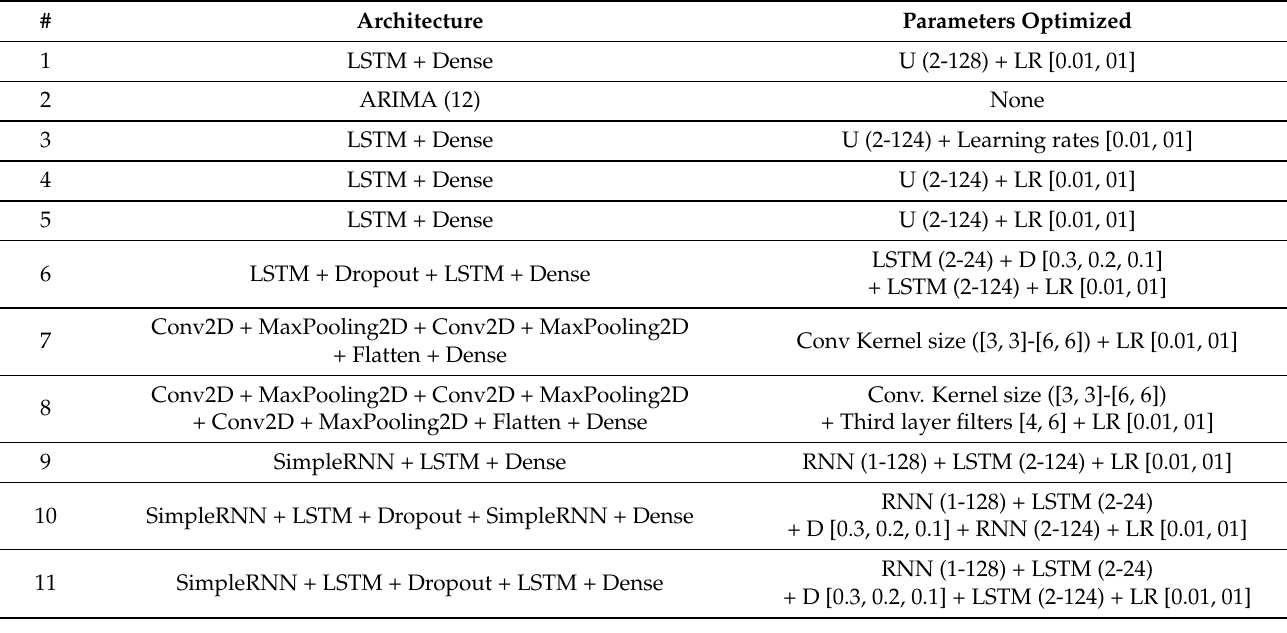
Table 2. Summary of the evaluated approaches with different configurations in terms of the number of Units in the LSTM layer (U), the Learning Rate (LR), and the Dropout rate